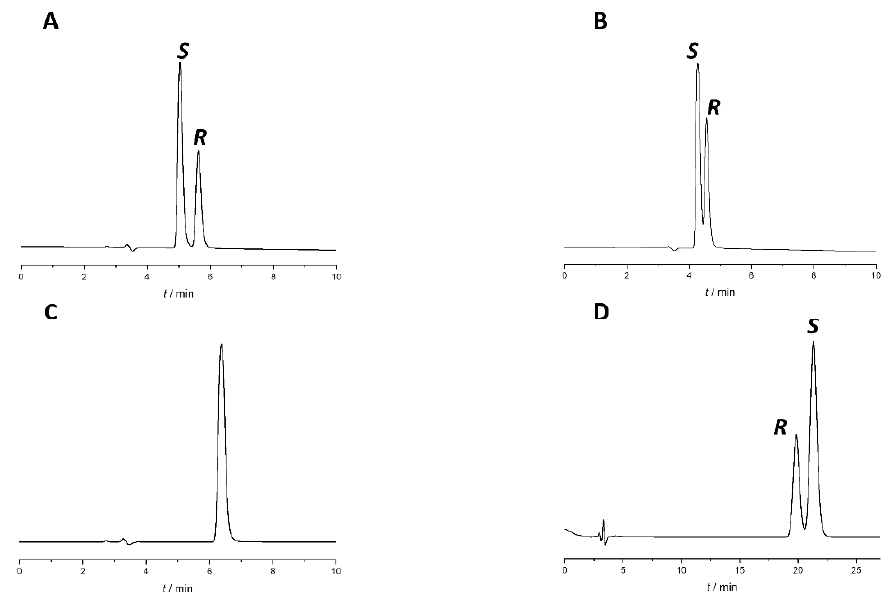
Figure 3. Effect of water content on separation of naproxen enantiomers using Lux Amylose-1 column. ( A ) EtOH:acetic acid 100:0.1 ( v / v ), ( B ) EtOH:water:acetic acid 90:10:0.1 ( v / v / v ), ( C ) EtOH:water:acetic acid 70:30:0.1 ( v / v / v )), ( D ) EtOH:water:acetic acid 55:45:0.1 ( v / v / v ). Flow rate: 0.5 mL/min, column temperature: 25 °C, detection at 230 nm.